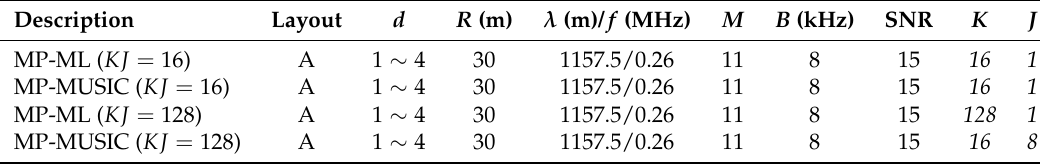
Table 6. Parameter setting in simulations of time